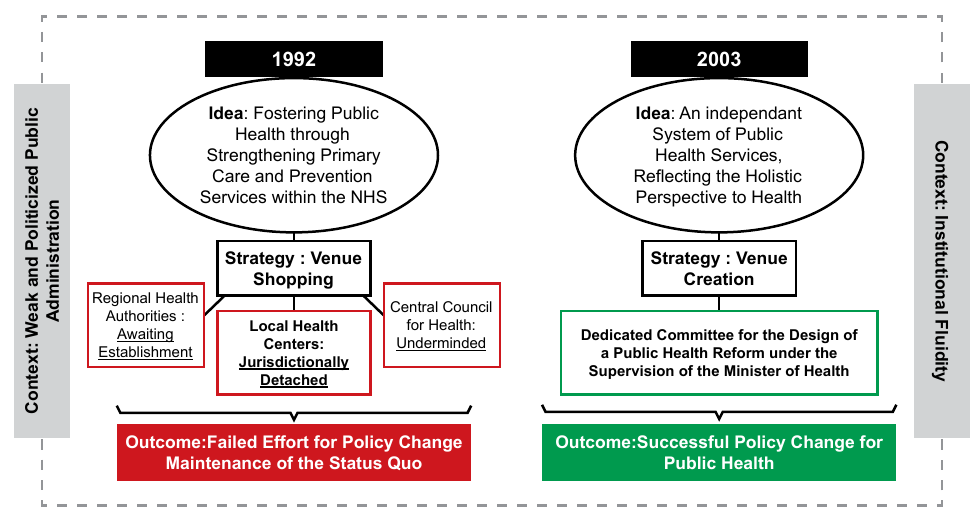
Figure 1: Venue creation as the favorable strategic option for policy change in public health in Greece (1992 vs